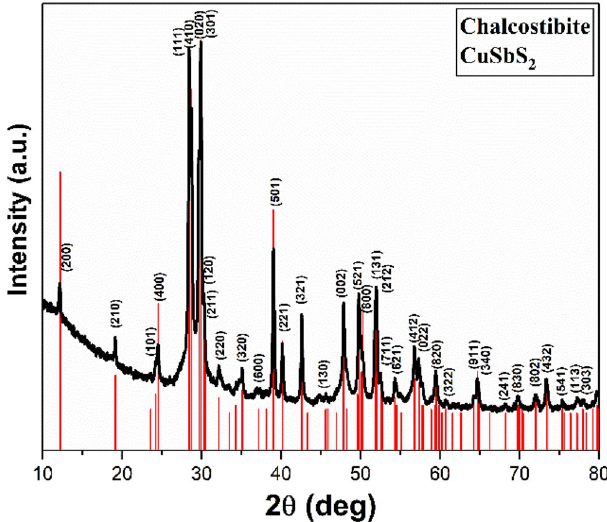
Figure 1. p-XRD pattern of chalcostibite CuSbS 2 nanomaterials prepared using 1: 1 molar ratio of Cu and Sb xanthates at 250 °C. Red lines show the positions of Bragg reflections from the standard reference pattern of orthorhombic CuSbS 2 (chalcostibite, ICDD: